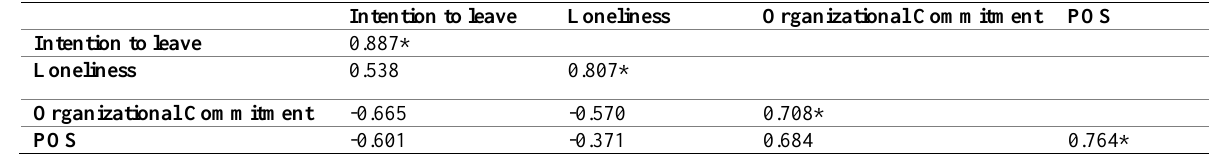
Table 3: Discriminant validity